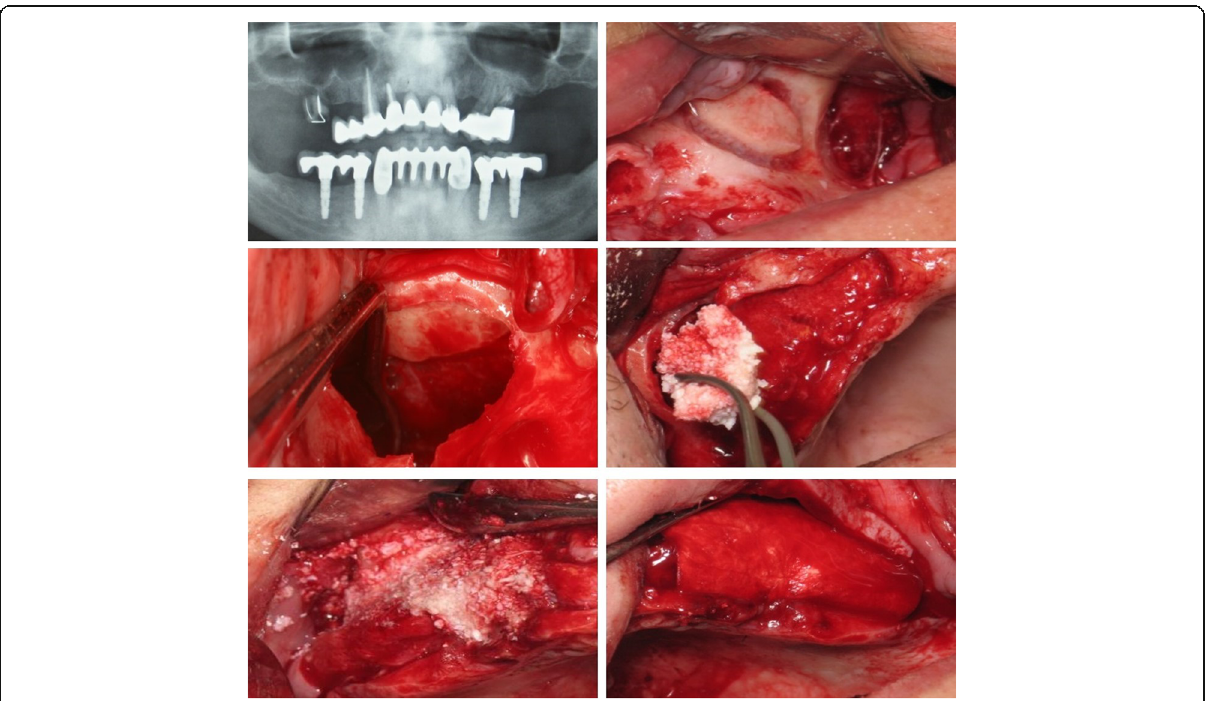
Fig. 1 Panoramic radiograph ( a ) of one patient receiving bi-lateral MSFA with the lateral window approach ( b ), where after sinus membrane elevation ( c ), one site was grafted with DBB + PRGF ( d ) and the other with DBB alone ( e ); the window was always covered with a collagen membrane